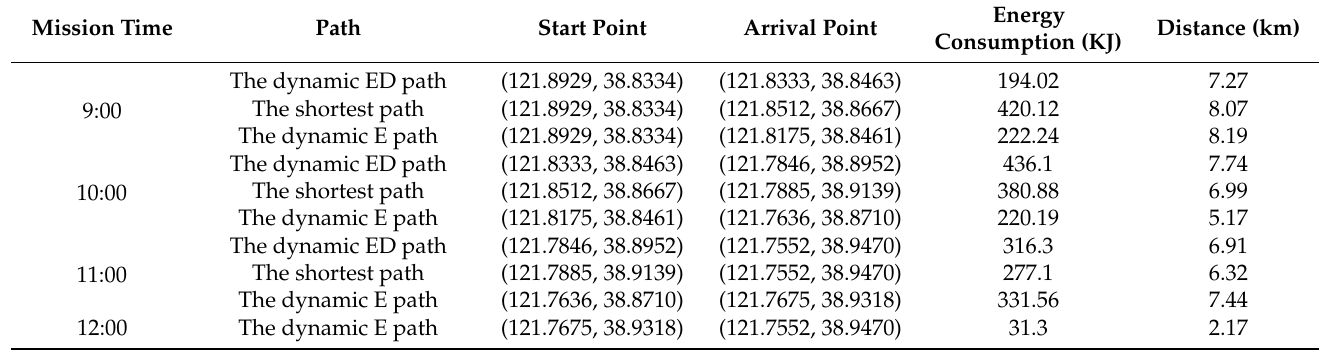
Table 9. Comparison of hourly dynamic energy-efficient path considers the distance, the shortest path, and hourly minimal energy-consuming path.